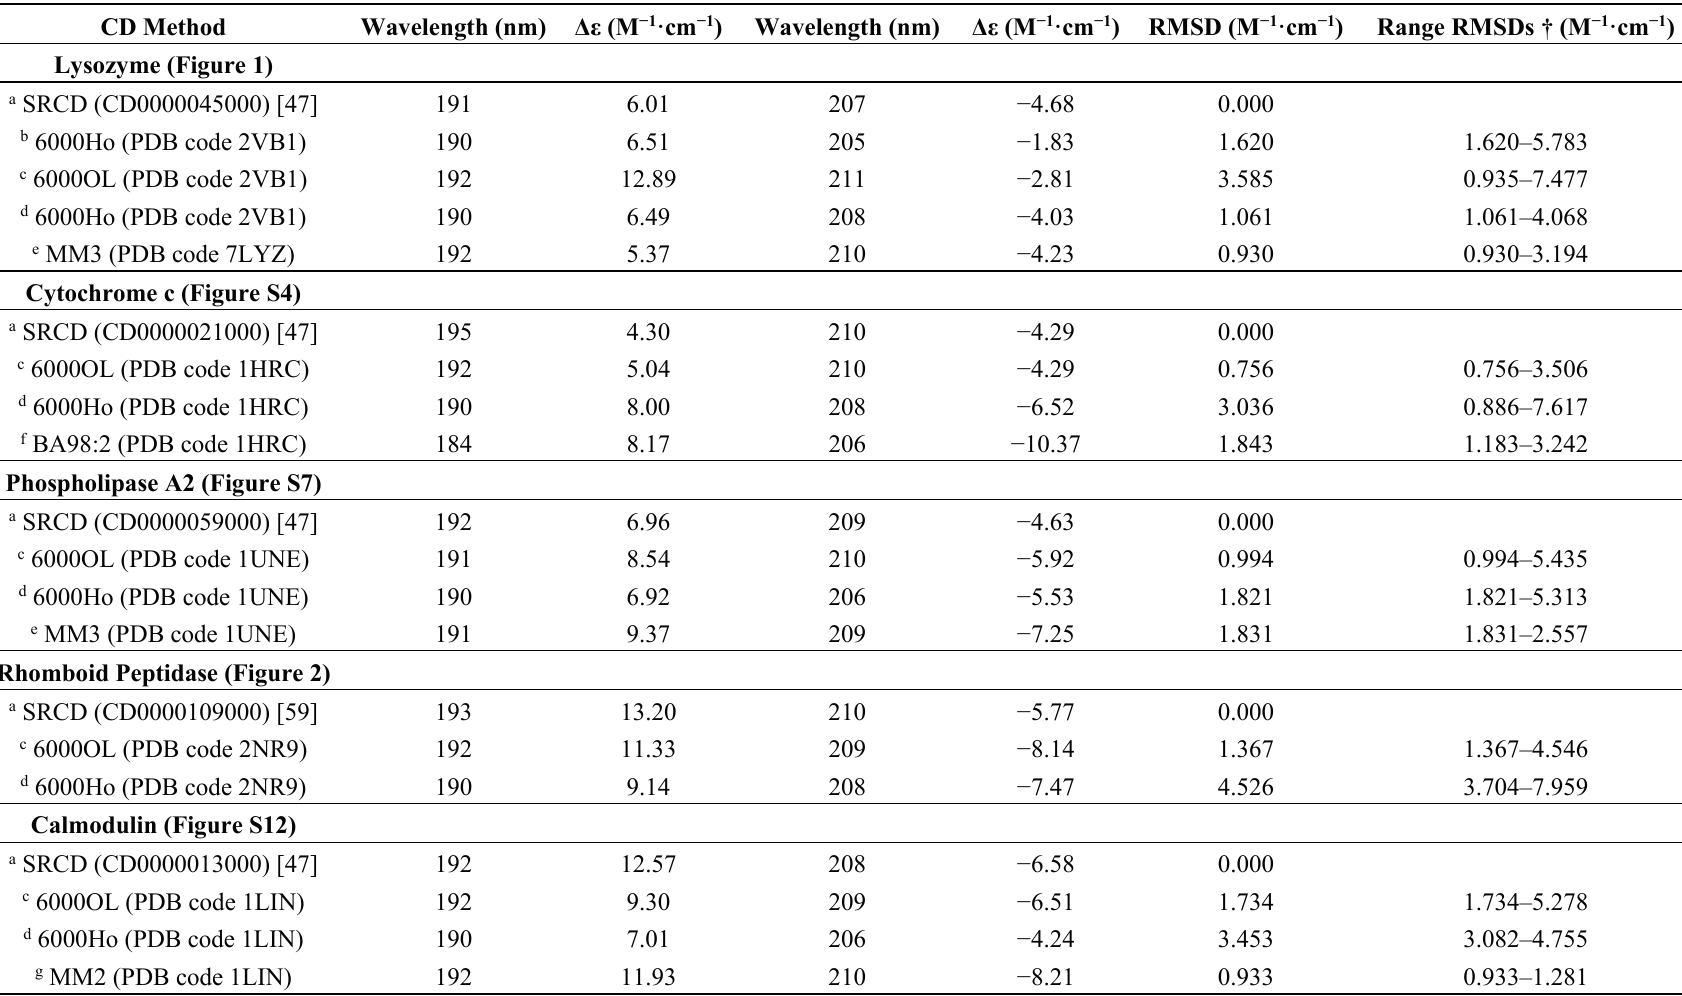
Table 1. CD Analysis of α -Helical Proteins. All RMSDs are calculated between 180 and 210